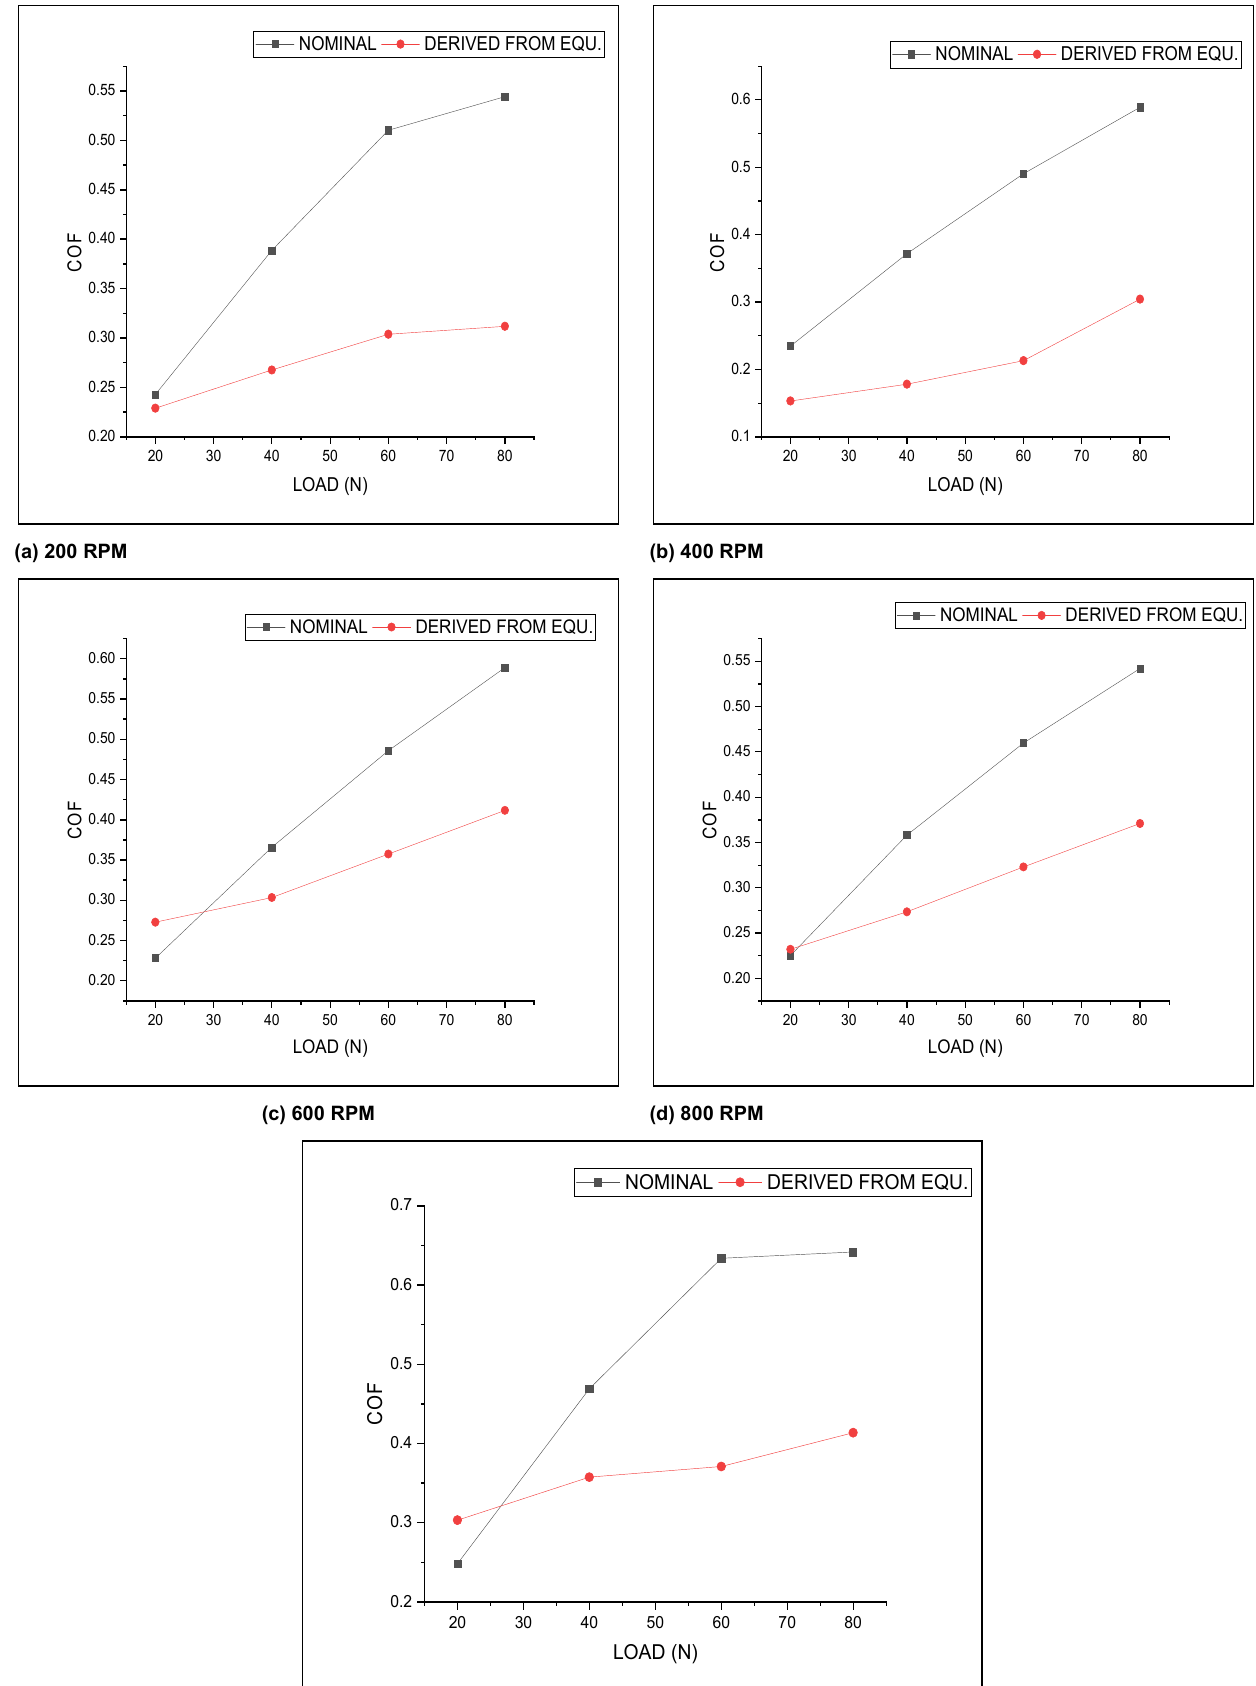
Figure 12. Comparison of COF through the nominal and derived